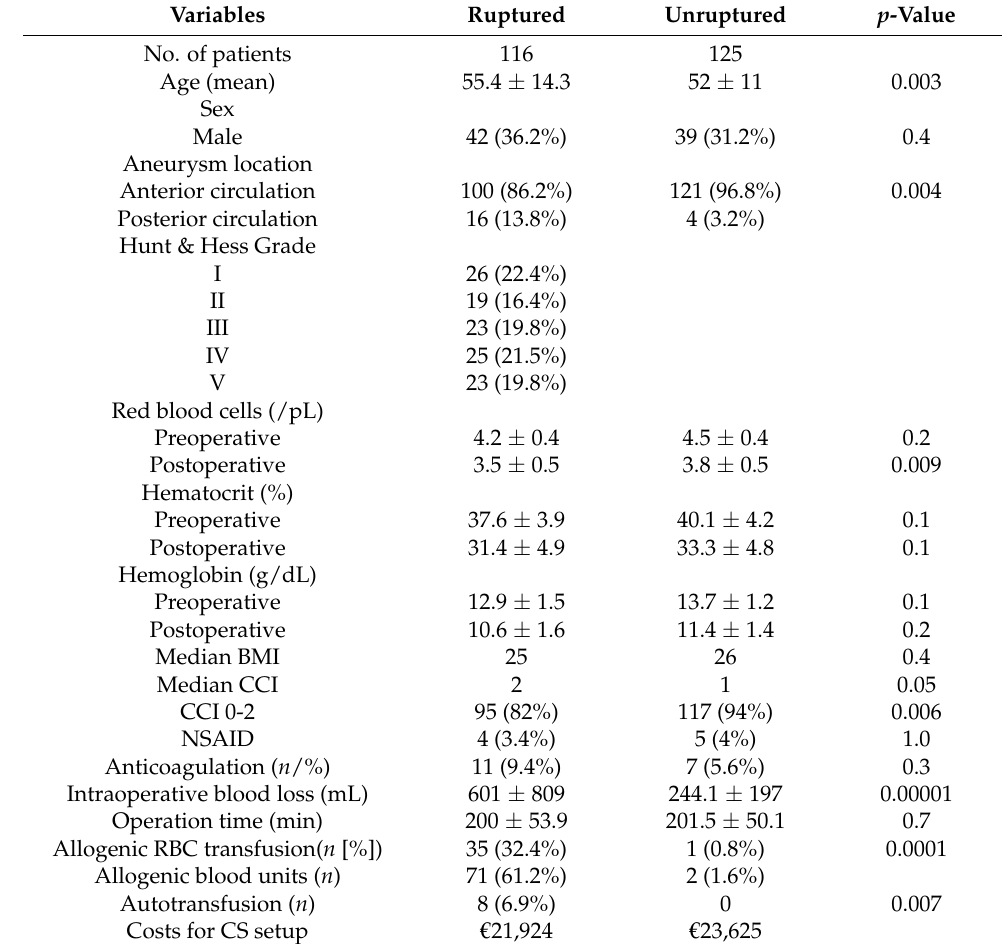
Table 1. Patients’ characteristics.